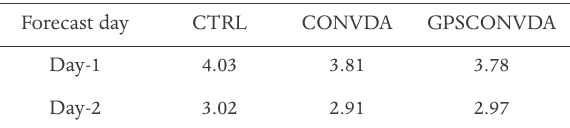
Table 2. MAE of the 24-hour accumulated precipitation (in mm) simulated in different experiments. The WRF initialized at 12UTC, January 31, 2014.